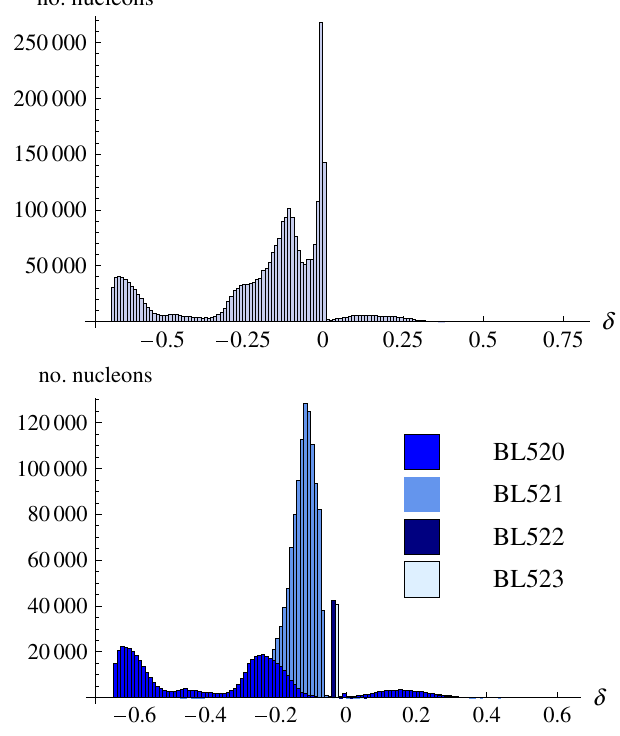
FIG. 14. (Color) The simulated distribution of (cid:8) calculated according to Eq. (3), using the FLUKA full method, of all high- energy nuclei except 208 Pb 82 þ coming out of the collimator (top) and of the ions lost within a 15 m interval upstream of each BLM (bottom) at 106 : 4 GeV = nucleon with parallel jaws. The heights of the bars show the number of nucleons belonging to ions having (cid:8) within a certain interval.